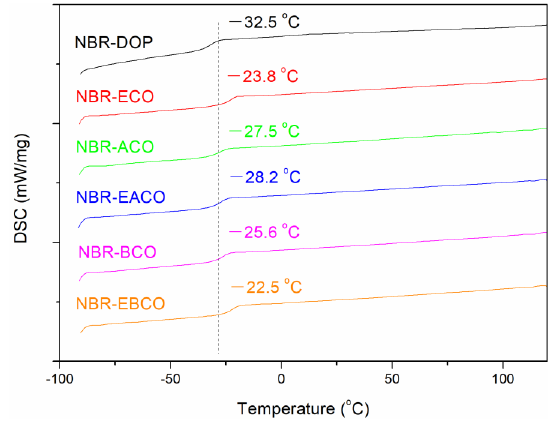
Figure 6. The glass transition temperature curves of NBR vulcanizates.